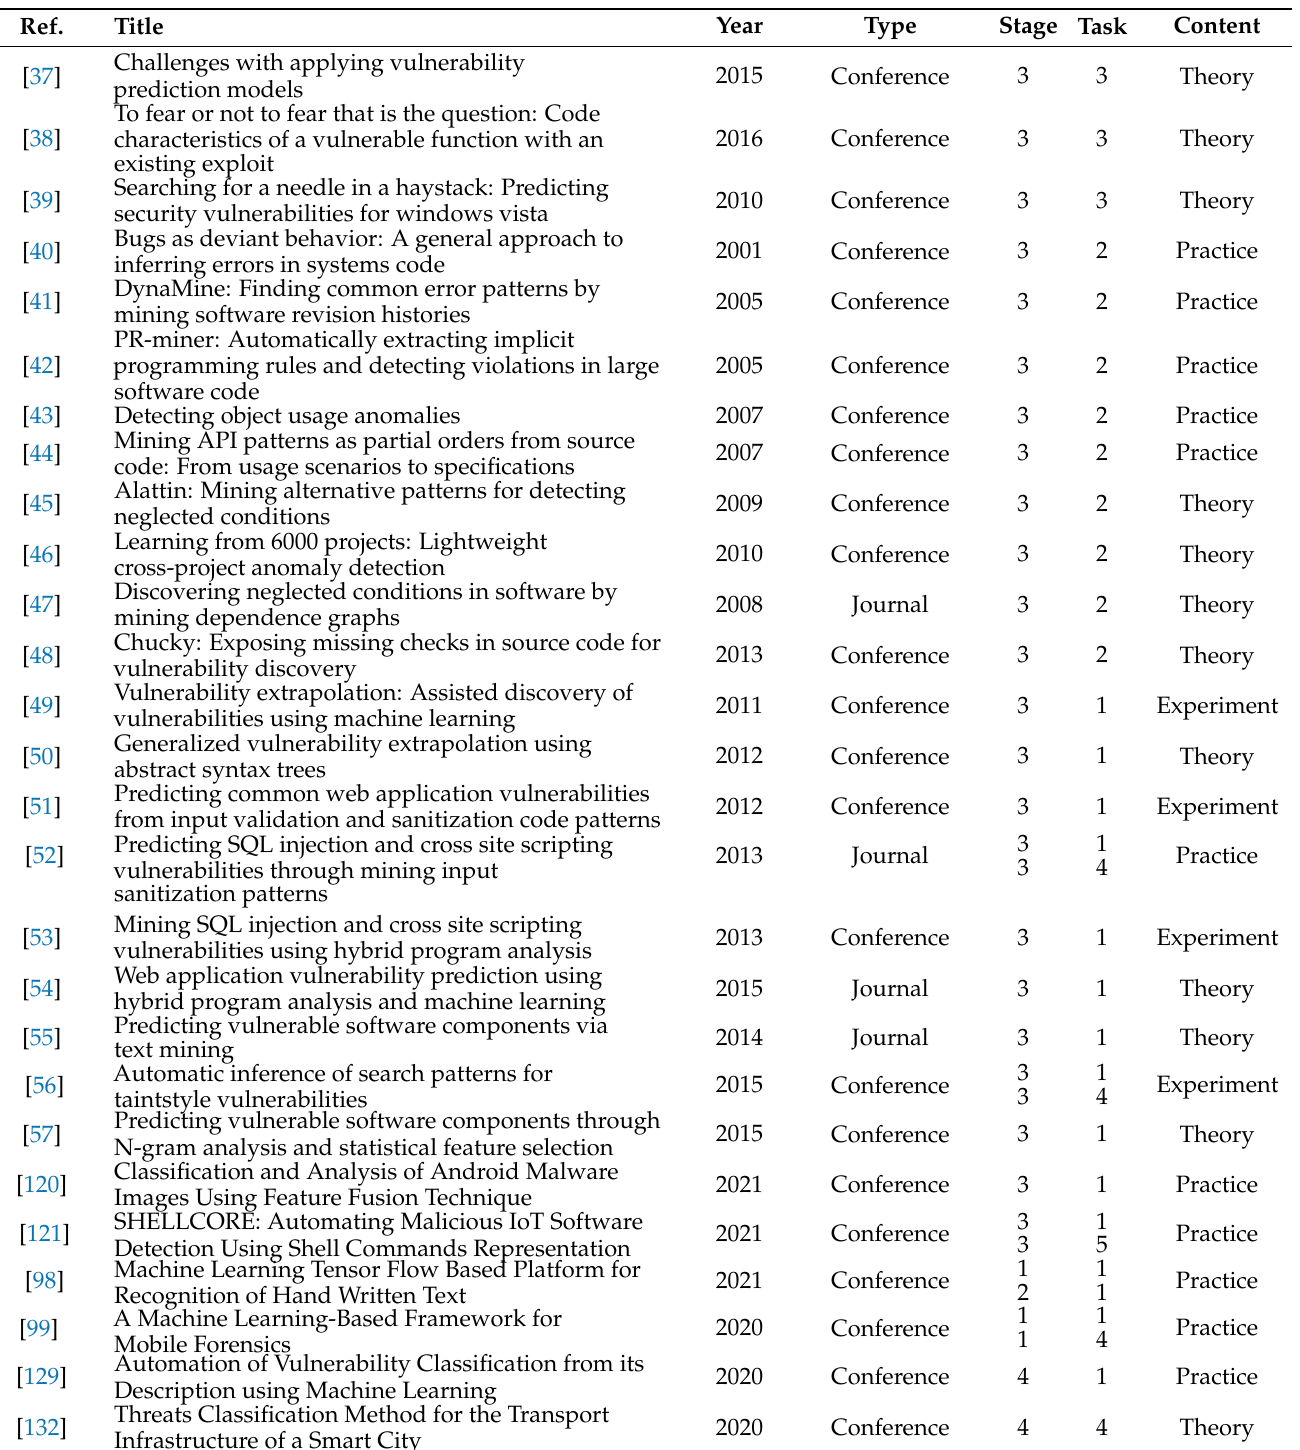
Table 5. Publication summary (Part 3).